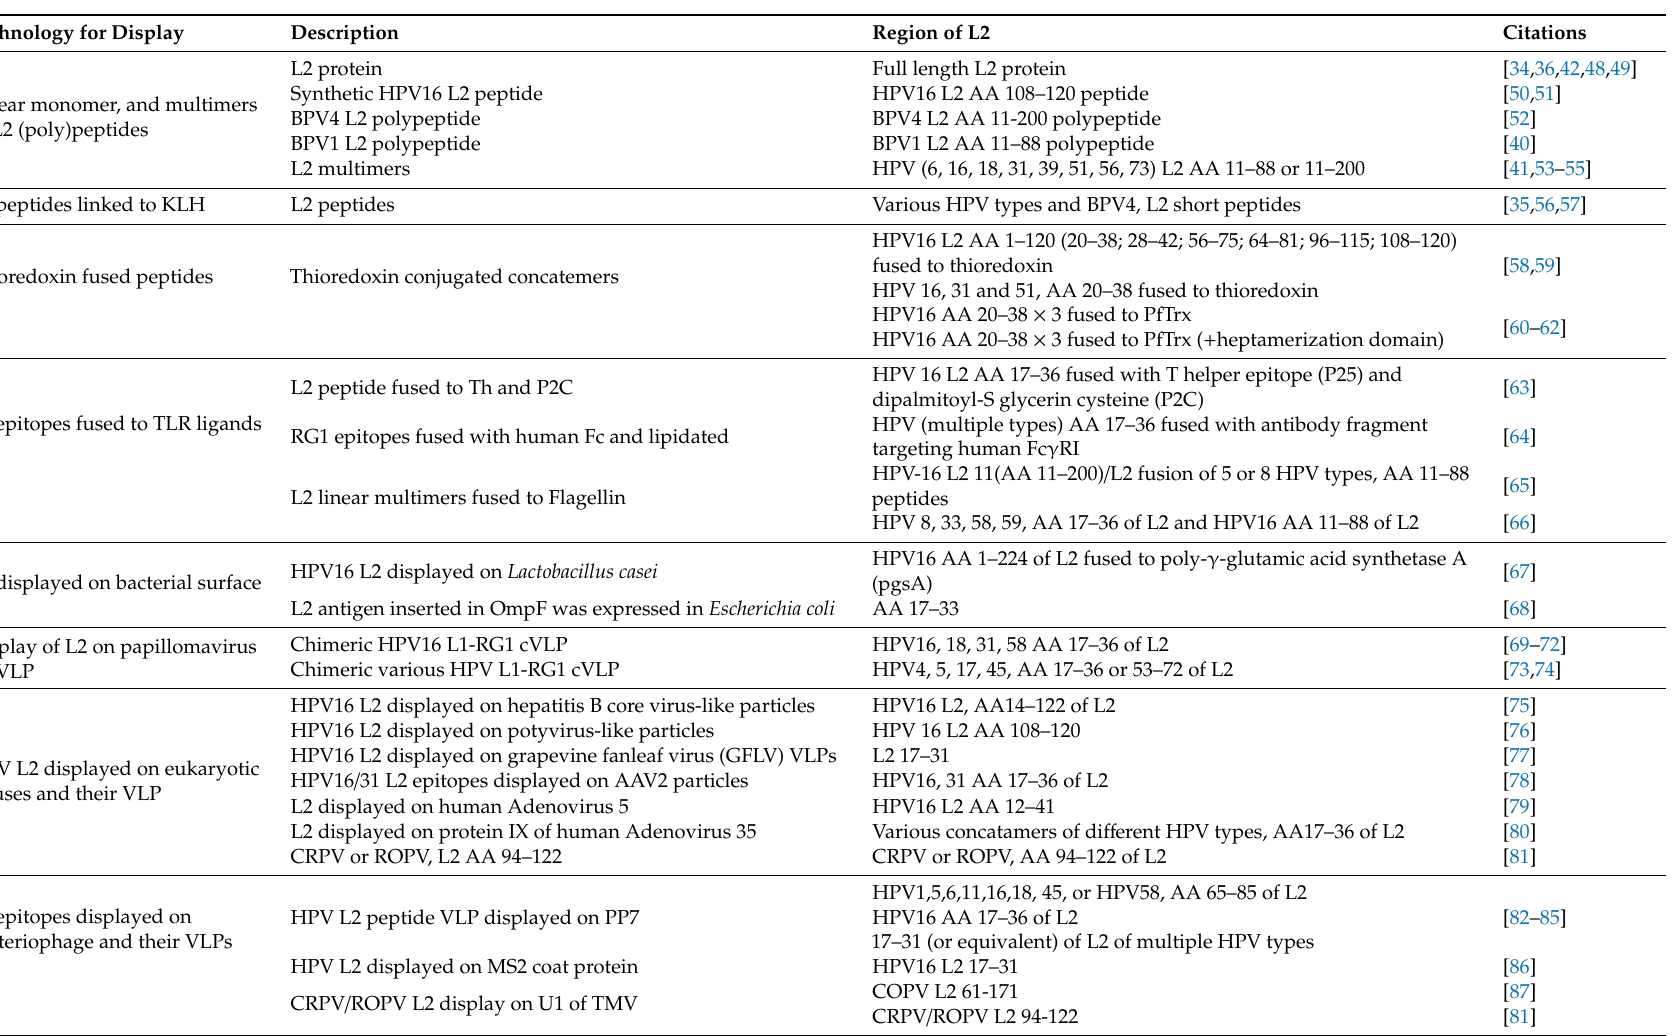
Table 1. Summary of published L2 vaccine